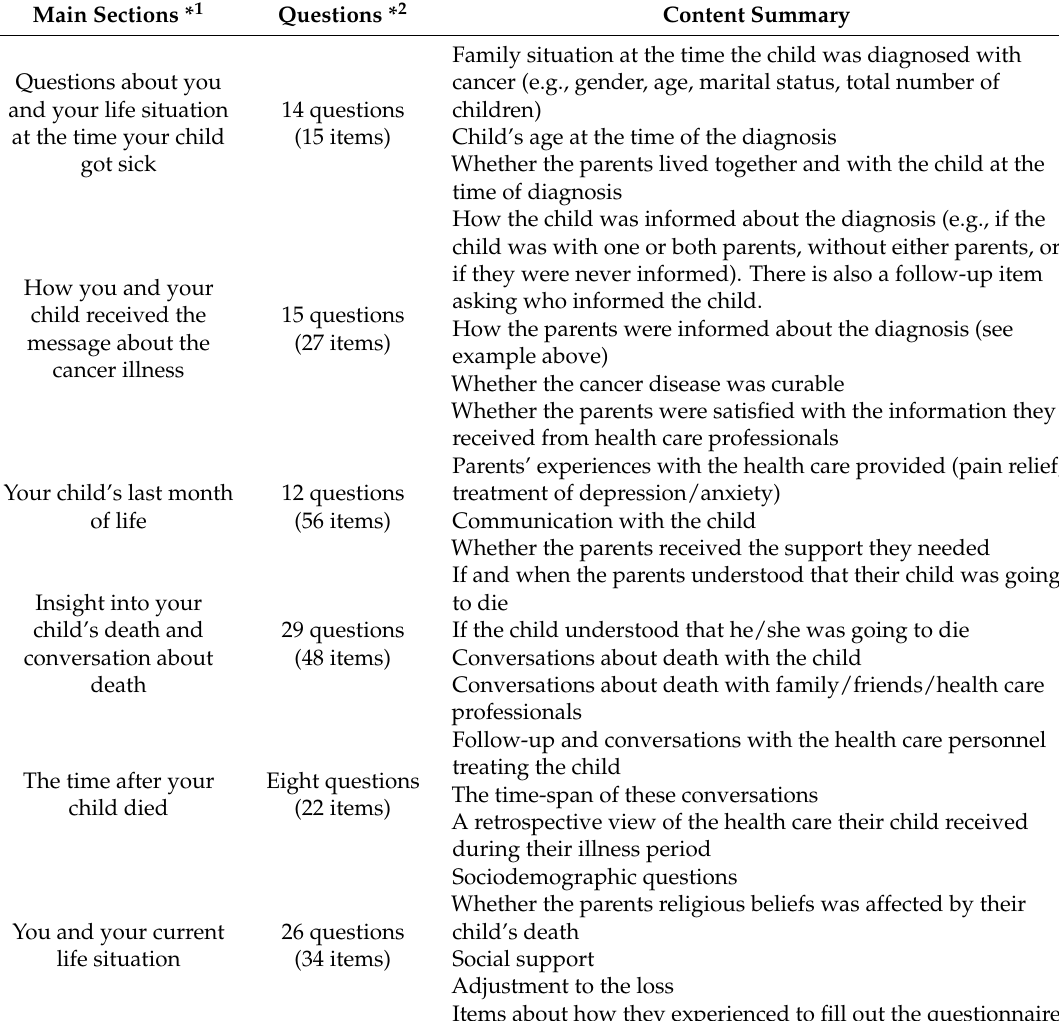
Table 1. Content of the Swedish Study-Specific